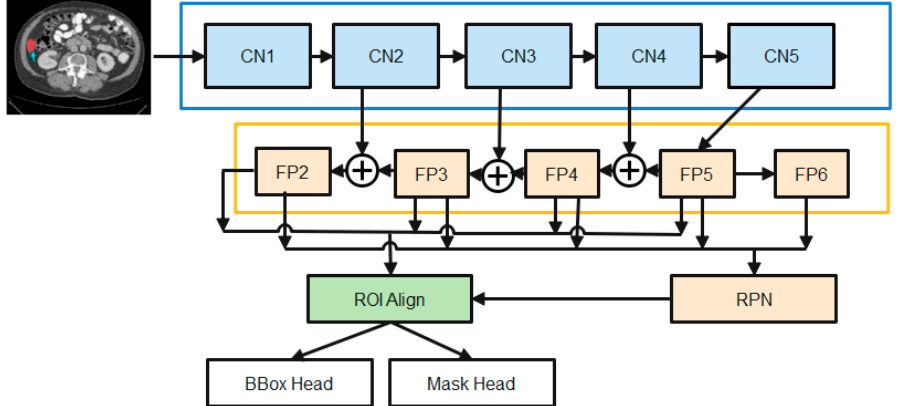
Figure 2. The diagrams of the Enhanced M-RCNN Framework.